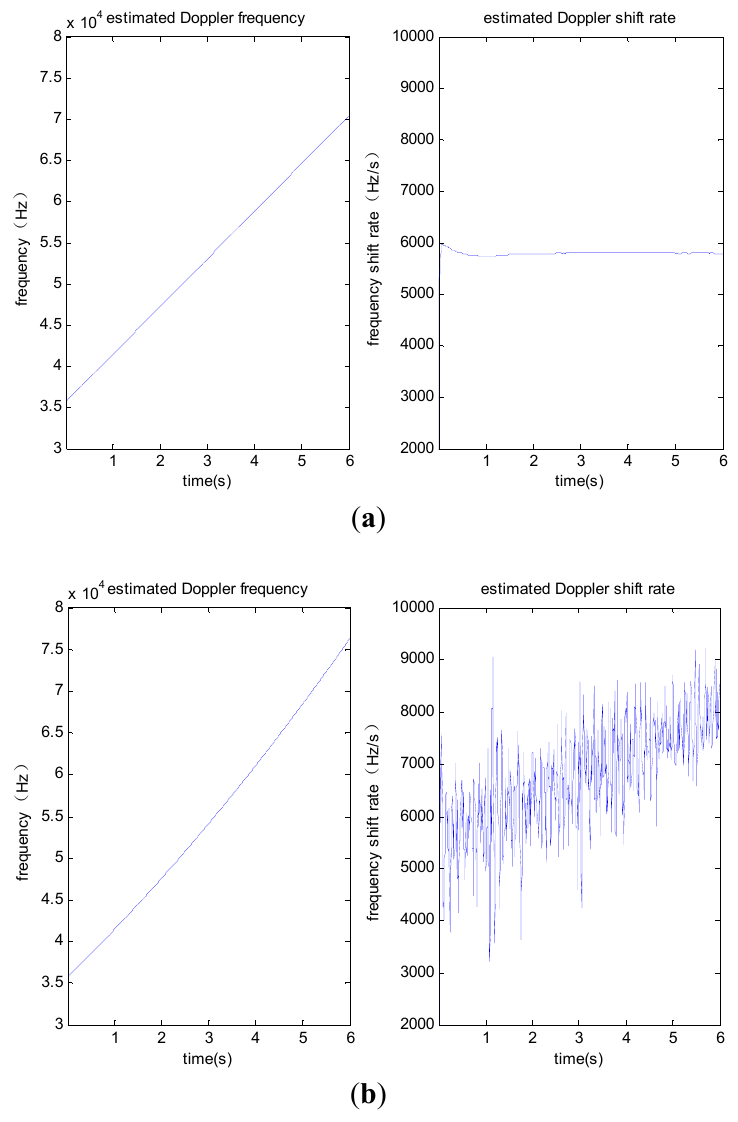
Figure 9. ( a ) Doppler frequency and Doppler shift rate estimated by PLL without assistance; ( b ) Doppler frequency and Doppler shift rate estimated by jerk aided